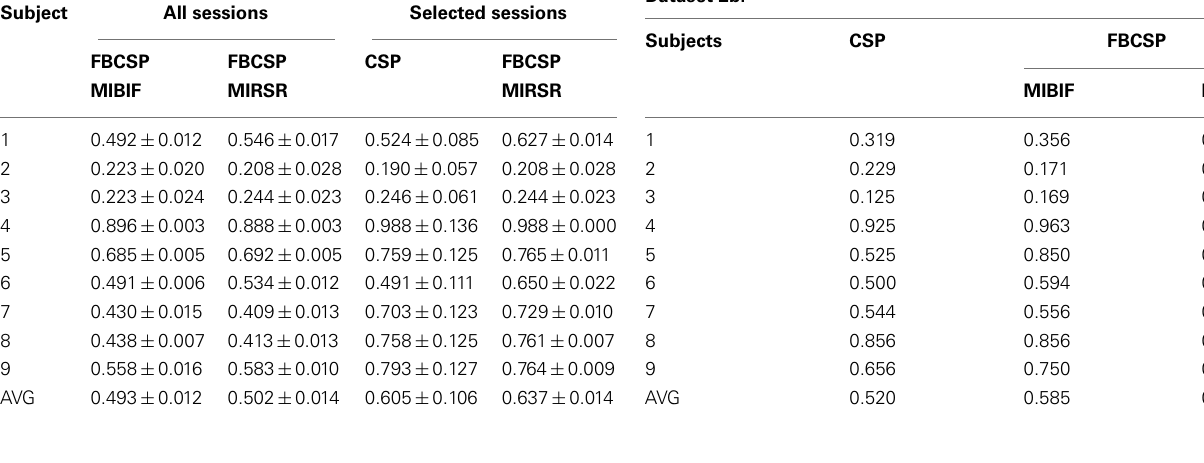
Table 4 | Classification results from using CSP and the FBCSP algorithm on the unseen evaluation data from BCI Competition IV Dataset